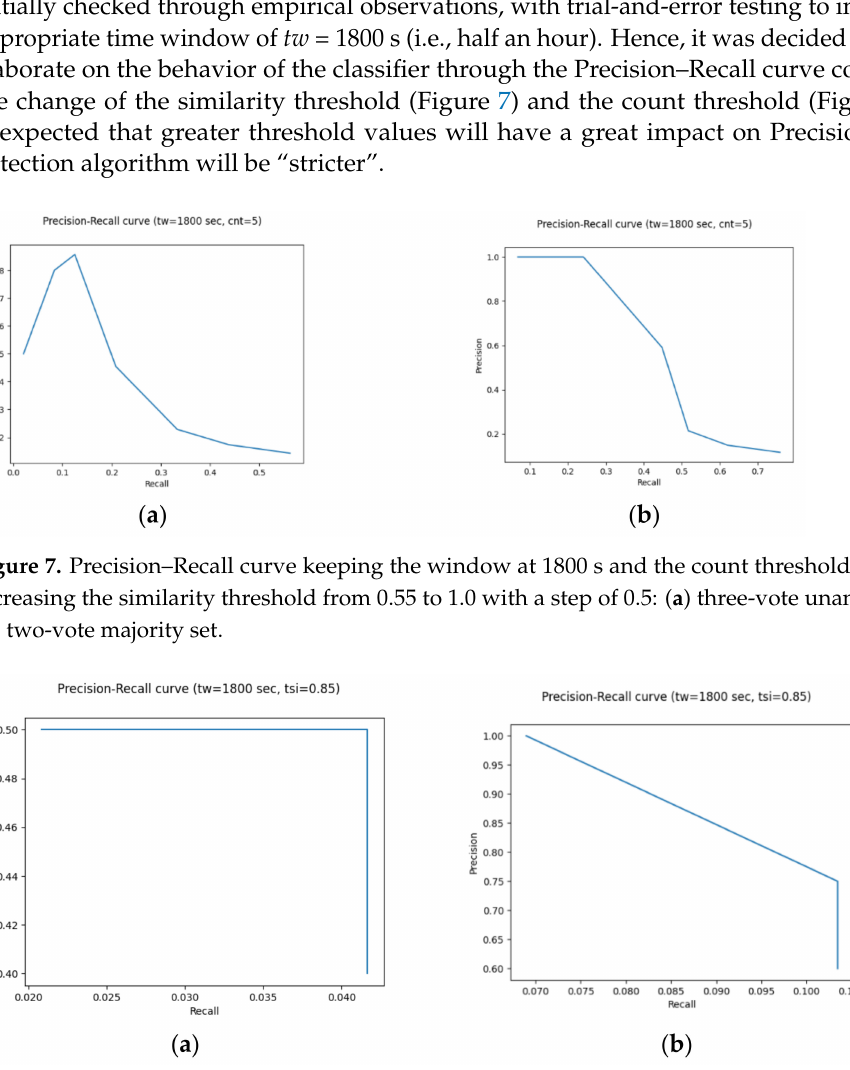
Figure 8. Precision–Recall curve keeping the window at 1800 s and the similarity threshold at 0.85, while increasing the count threshold from 3 to 13 with a step of 1: ( a ) three-vote unanimous set; ( b ) two-vote majority